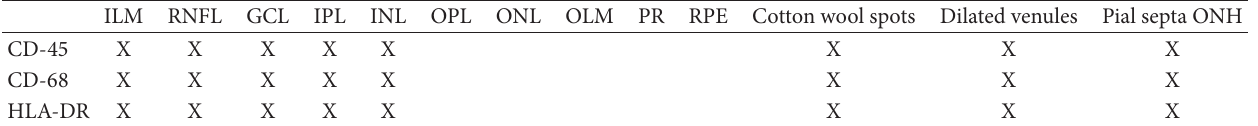
Table 4: Distribution of microglia in preproliferative diabetic retinopathy